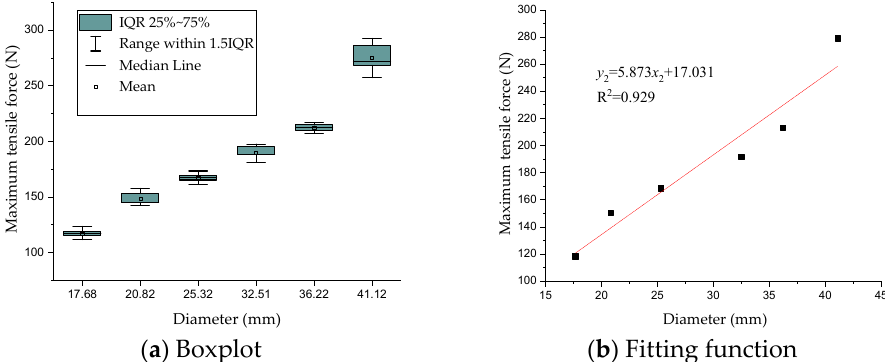
Figure 6. Boxplot and fitting function of longitudinal maximum tensile force.